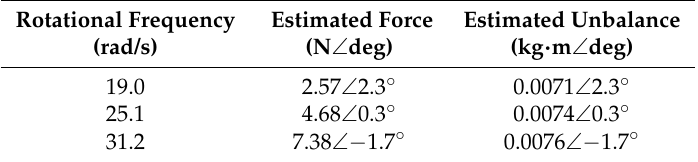
Figure 14. Steady-state behavior of test system at rotational speed of 31.2 rad/s (5 Hz) with ( a ) exact linearizing control with Harmonic Vibration Control implementation ( b ) linear approximation control with synchronous (unbalance) control implementation. Table 4. Unbalance estimation results from nonlinear force model: actual unbalance was 0.0074 ∠ 0 ◦